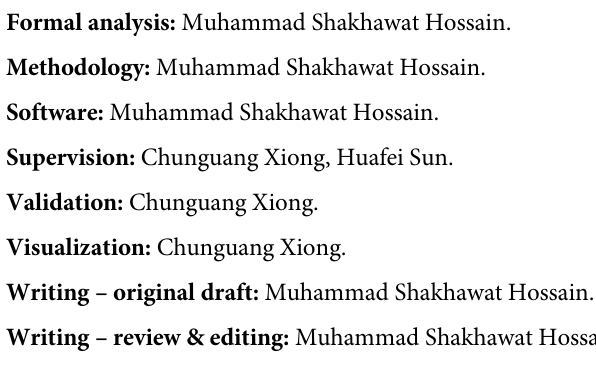
Table 6. Errors k u − u